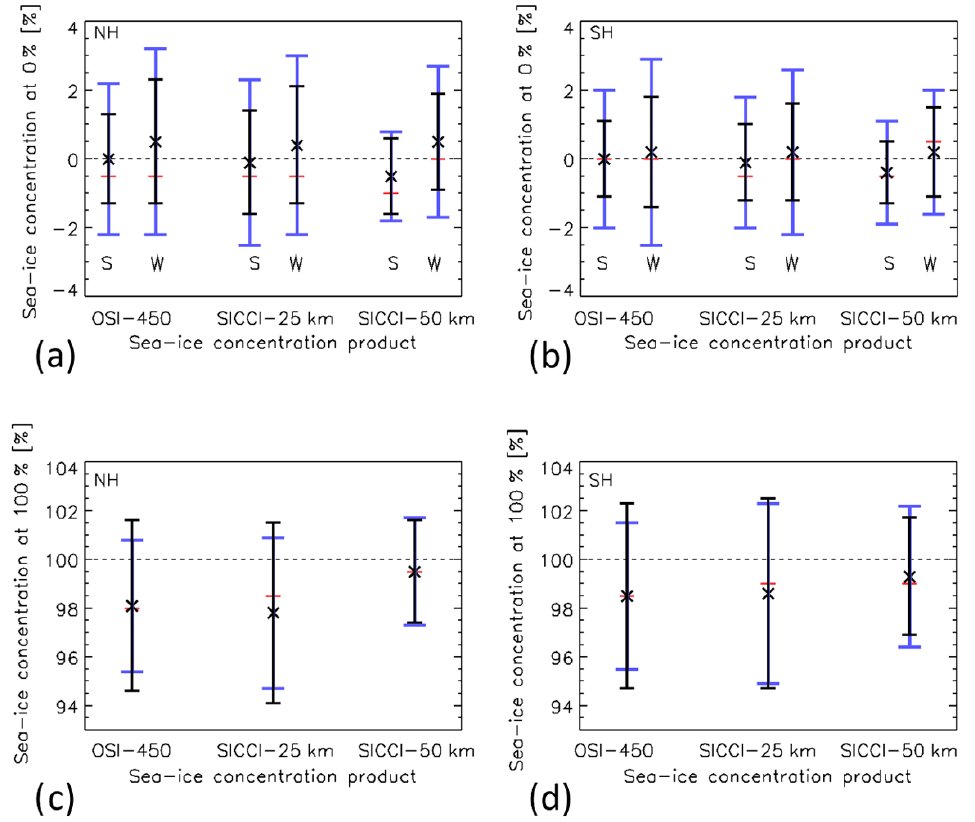
Figure 12. Summary of histogram statistics from Figs. 10 and 11 for SIC = 0% (a, b) and SIC = 100% (c, d) for the Arctic (a, c) and the Antarctic (b, d) . Crosses and black bars denote the mean SIC ± 1 standard deviation of the standard error. Red horizontal bars denote the modal SIC. Blue bars denote the range covered by the mean SIC ± 1 standard deviation of the total uncertainty. Letters S and W in (a) and (b) refer to summer and